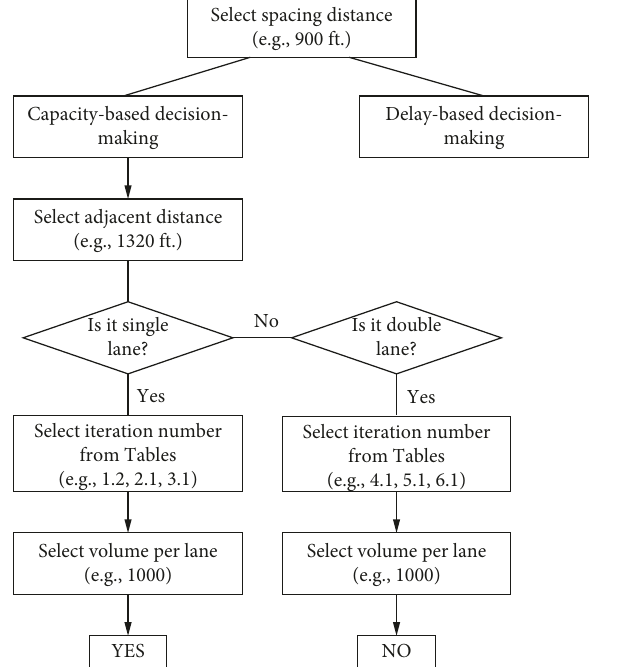
Figure 6: Decision-making framework for switching from conventional intersection to the CFI. Delay-based decision-making also follows the same flow of activities as capacity-based decision-making (see Tables 3 and 4 for